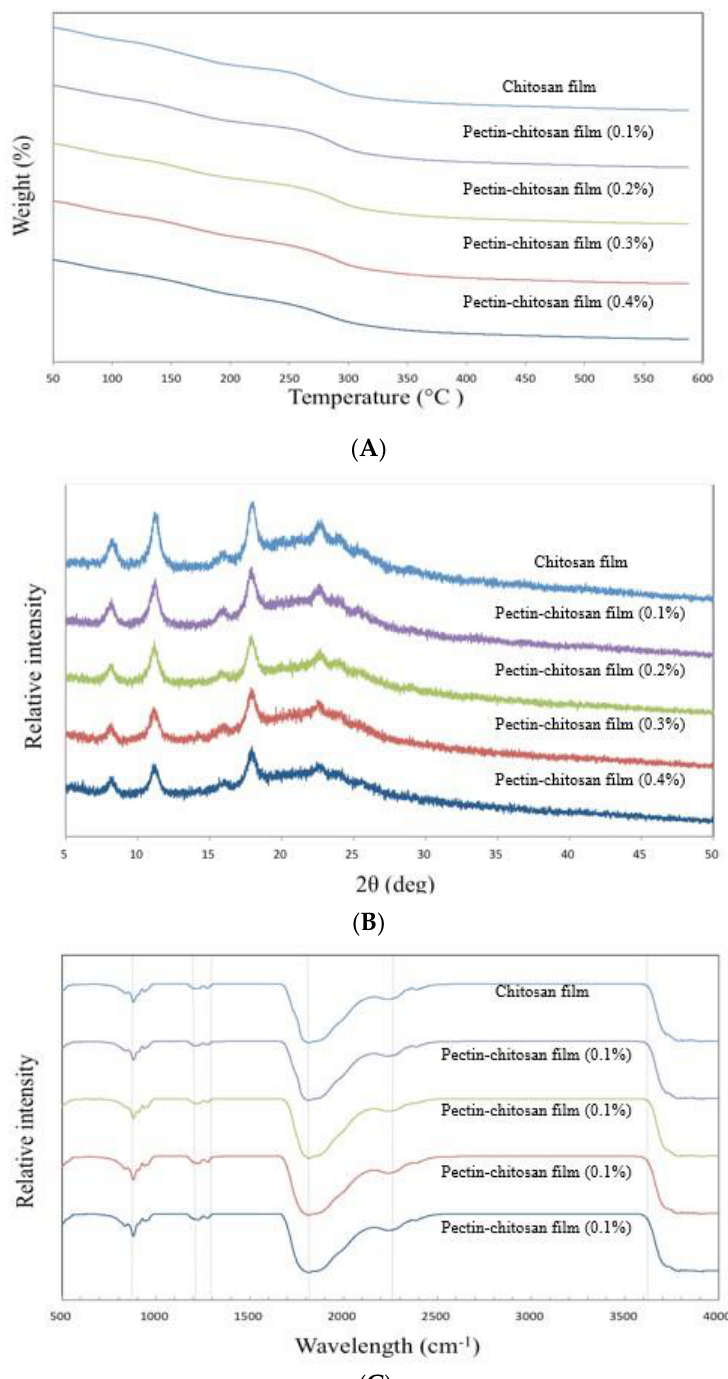
Figure 3. TGA analysis ( A ), XRD patterns ( B ), and FTIR spectra ( C ) of films.